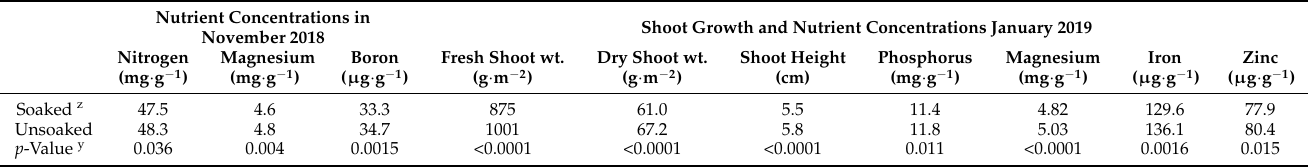
Shoot Growth and Nutrient Concentrations January 2019